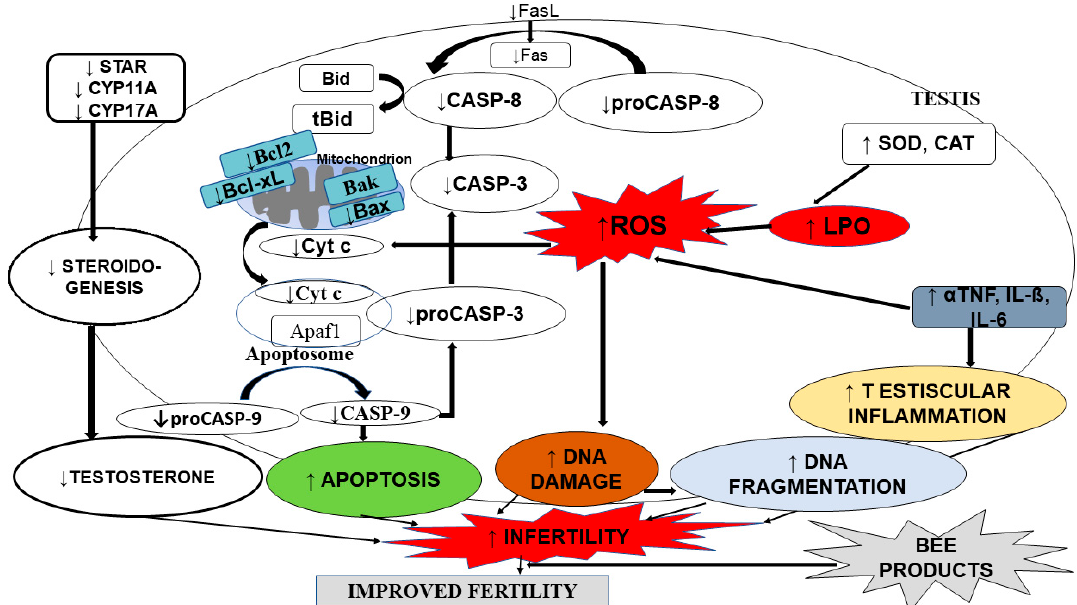
Figure 1. Factors involved in testicular impairment (adapted from [60]). Apaf1: Apoptotic protease activating factor 1; Bak: Bcl2 Antagonist/Killer;Bax: Bcl-2-like protein 4; Bcl2: B-cell lymphoma 2 ; Bid: Bax-like BH3 protein; CASP-3: Caspase 3;